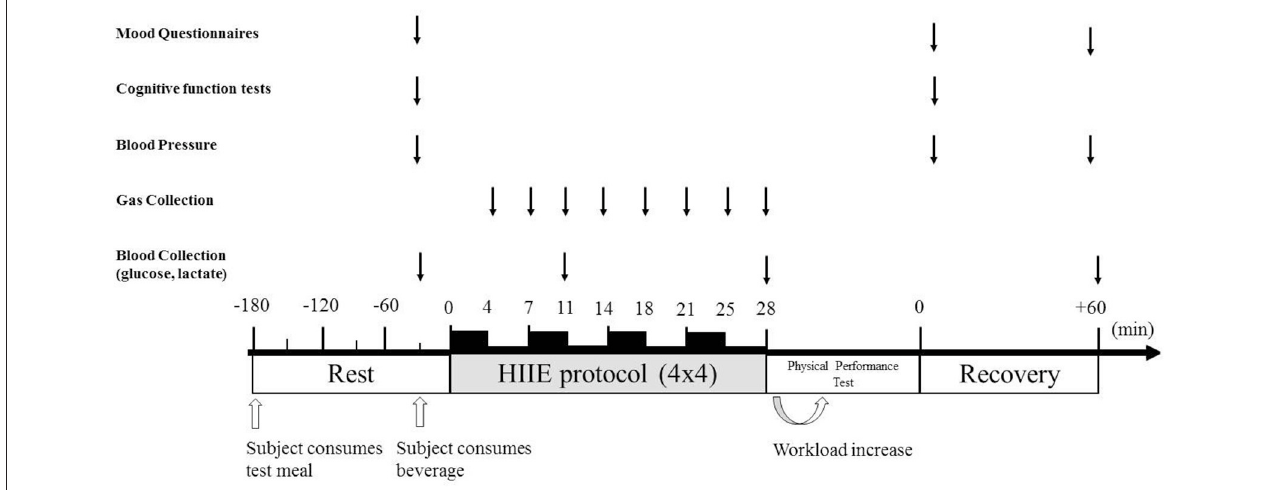
FIGURE 1 | Experimental protocol. Protocol timeline illustrates mood state questionnaires, cognitive function tests, blood pressure collection, gas collection, blood collection, exercise periods, and timing of ingesting high-carbohydrate and high-protein meal or fasted condition before exercise and either isotonic beverage, whey protein beverage or water 30min before